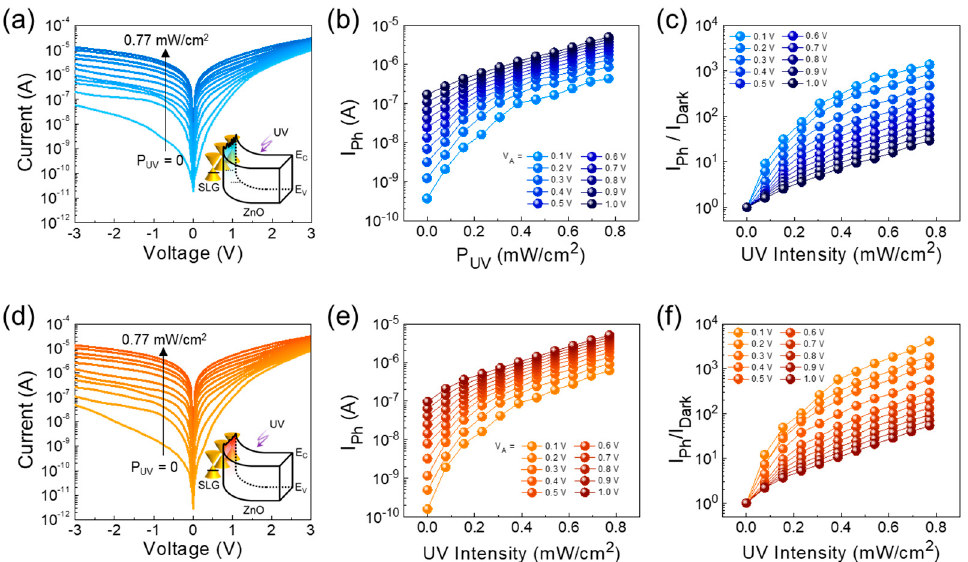
Figure 7. Comparison of the photoresponse characteristics between the ZnO / AT-SLG and the ZnO / TC-SLG Schottky PDs: I–V characteristics under 365-nm UV light illumination for the ( a ) ZnO / AT-SLG and the ( d ) ZnO / TC-SLG Schottky PDs, I Ph as a function of P UV for the ( b ) ZnO / AT-SLG and the ( e ) ZnO / TC-SLG Schottky PDs, and I Ph / I Dark ratio as a function of P UV for the ( c ) ZnO / AT-SLG and the ( f ) ZnO / TC-SLG Schottky PDs.